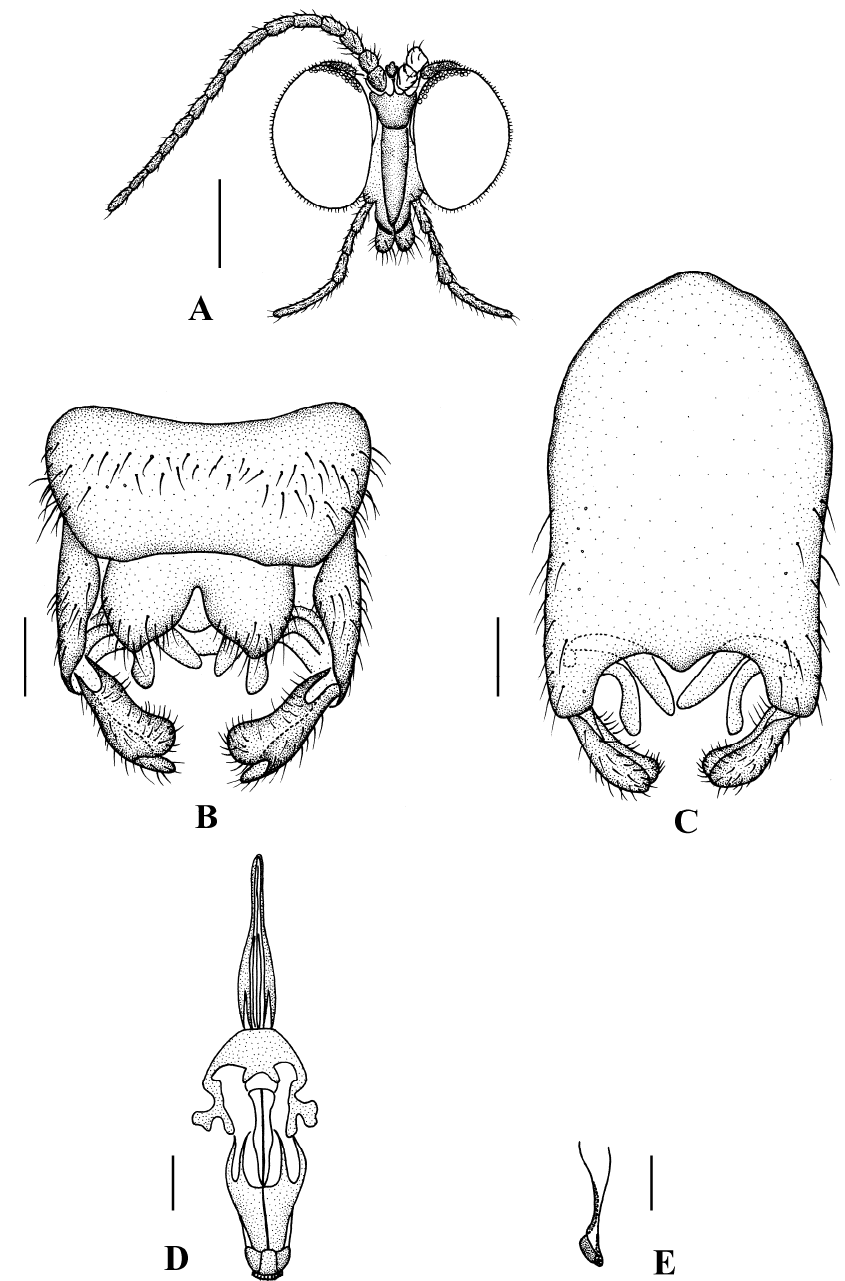
ure 8C) slightly brown apically, sc brown; veins brown. Sc rudimentary, not ending at the base of Rs; Rs slightly curved basally, 1.2 times as long as r-m; R 4 wavy, the length from the end of R 1 to end of R 4 shorter than the length from the end of R 4 to end of R 5 ; r-m straight, included angle between r-m and Rs less than 90 degrees; the length from the end of M 1 to end of M 2 as long as the length from the end of M 2 to end of CuA 1 . The base of halter is pale, the apex of halter brownish black, with brownish-black hairs.